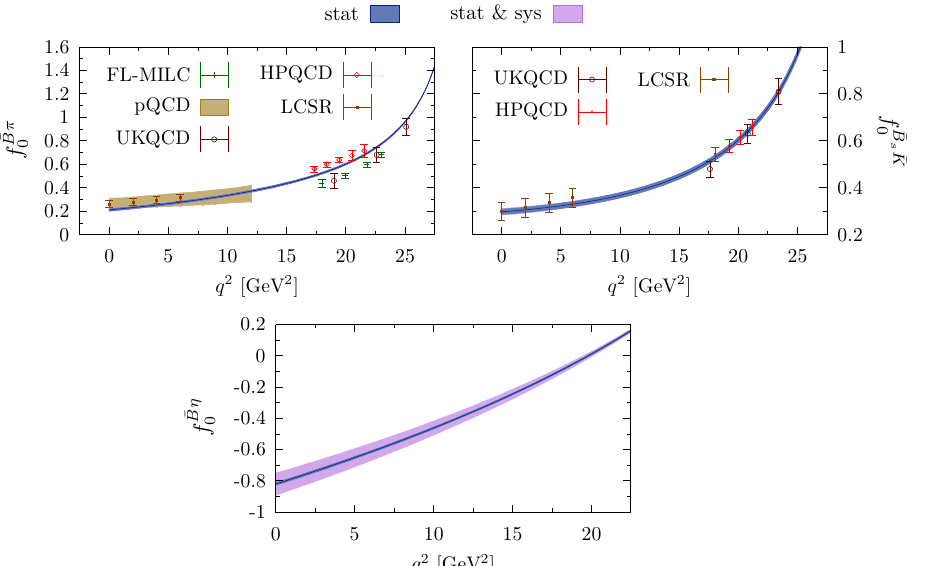
shown. The systematic uncertainties are inherited from the errors on the LECs quoted in Ref. [56], that enter in the definition of the chiral amplitudes, and are added in quadratures to the statistical uncertainties to obtain the outer bands. To estimate the systematic uncertainties for each set of LECs we re-do the best